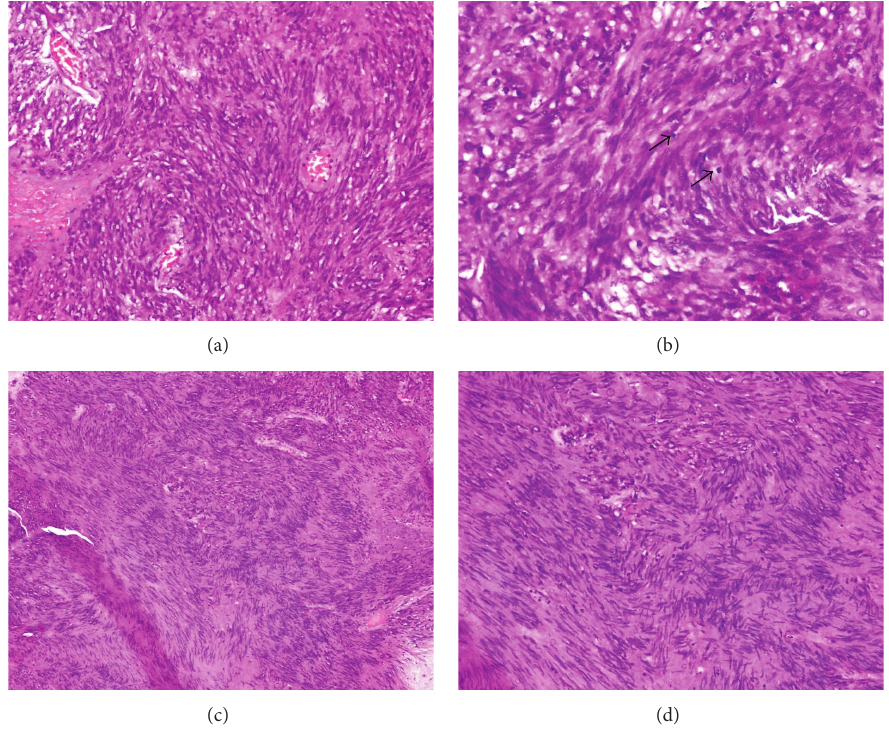
Figure 5: (a) Interlacing fascicles of spindle cells (H&E × 200), (b) high magnification demonstrating fusiform cells with pointed ends. Mitotic figures can also be identified (arrow), (H&E × 400), (c) & (d) focal areas featuring Vecoy body formation.